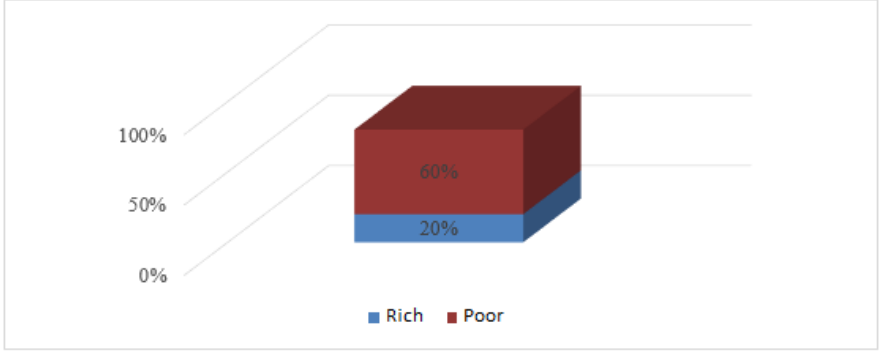
Figure 3. Income concentration between rich and poor. Source: INE/IBEP. With no margin for error, it can be stated that there is a poor distribution of income. Figure 4 shows the concentration of income in Angola.